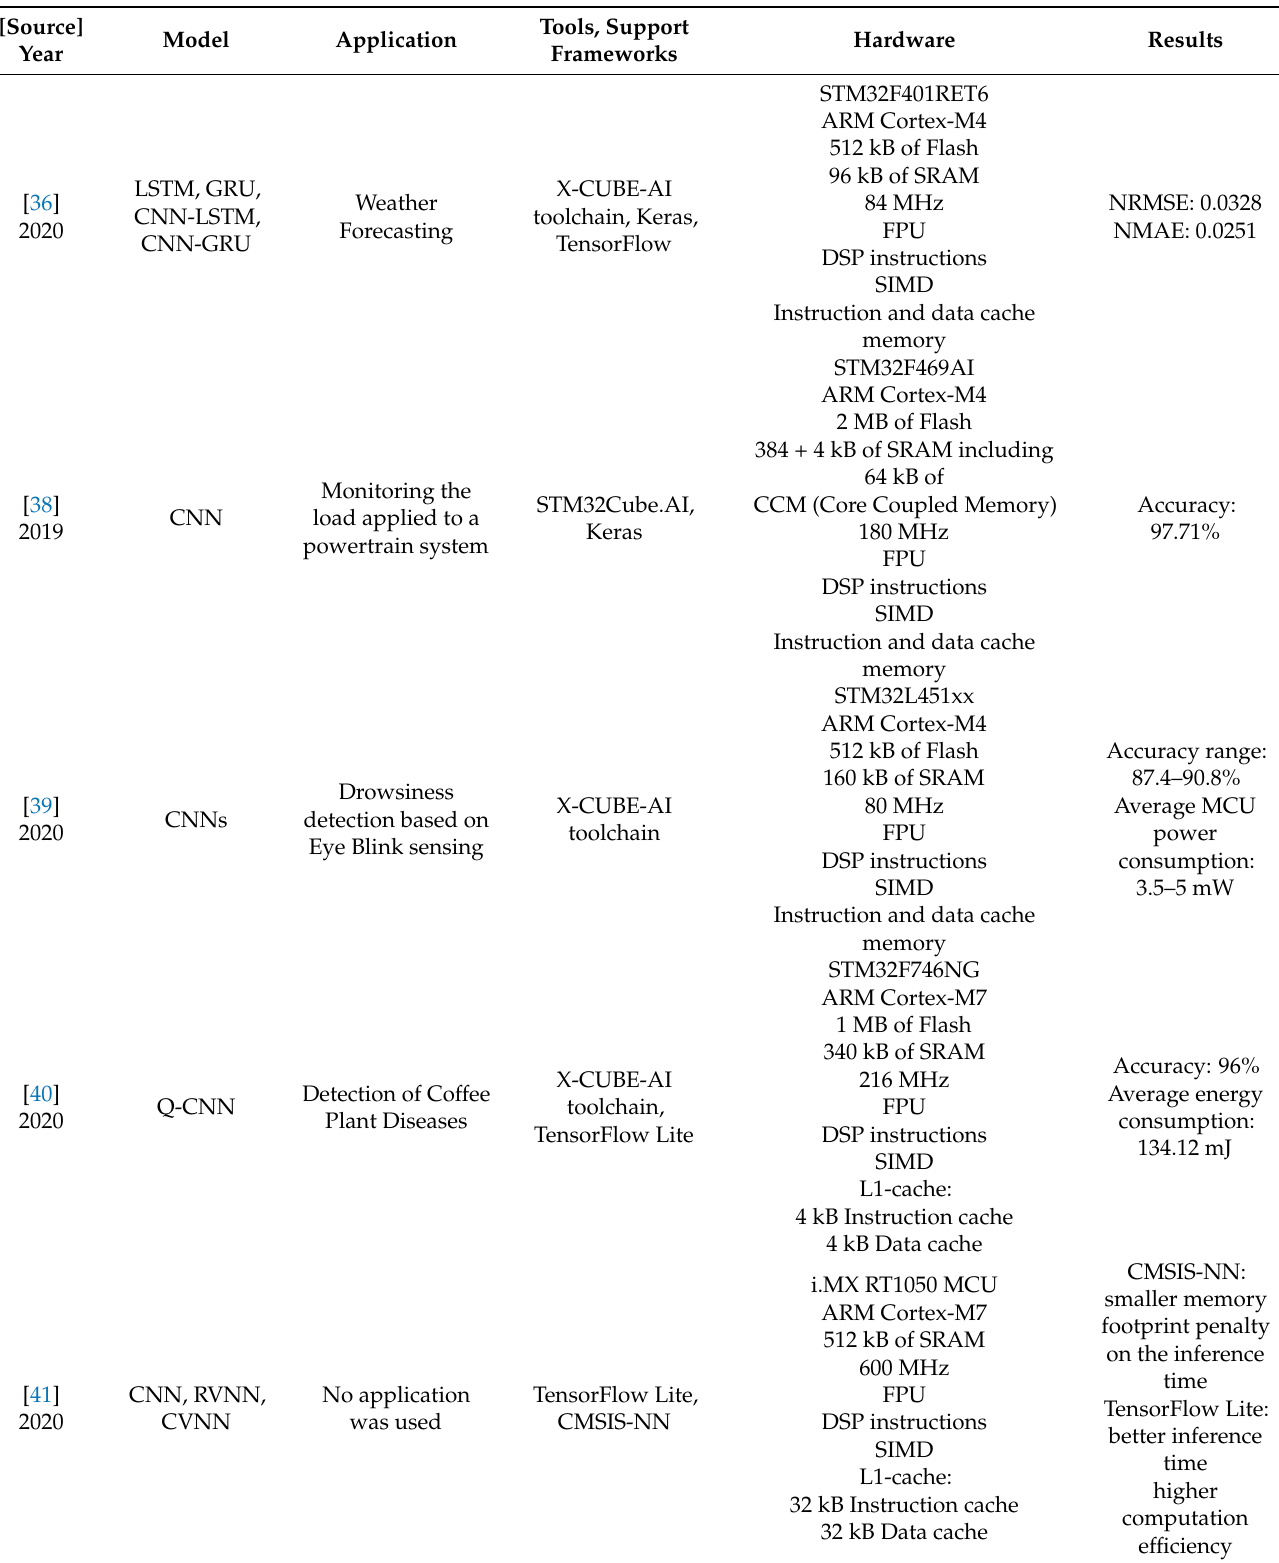
Table 1. Summary of the selected works on deep learning inference with ARM